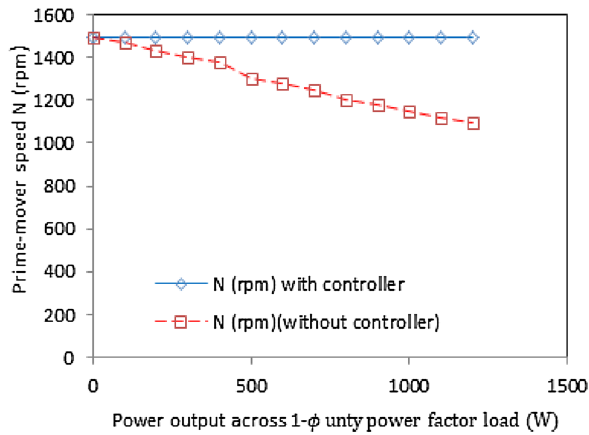
Fig. 16 Comparison of outcomes attained for prime-mover speed with and without EGLC controller